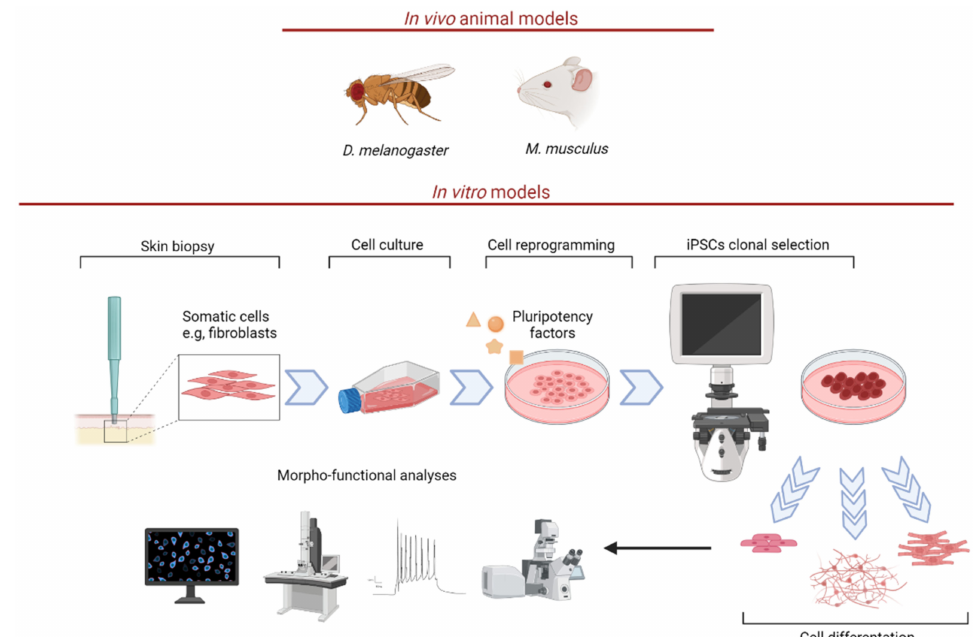
Figure 2. RTD in vivo and in vitro models. Proper RTD animal models include M. musculus and D. melanogaster. Note that C. elegans was also used to mimic human RF metabolism deficiency. In vitro models include patient-specific fibroblasts and iPSCs, which can be differentiated into MNs. Indeed, skin biopsy-derived fibroblasts can be reprogrammed into iPSCs, thanks to the introduction of specific pluripotency factors. Human iPSCs may be differentiated into cell types. In the figure, as an example intestinal epithelium, muscle, and neurons, as representative derivatives from endoderm, mesoderm and ectoderm germ layers, are illustrated. Neurons may be studied using diverse mor- phofunctional approches (e.g., confocal and electron microscopy, electrophysiology) The figure was created with BioRender.com (accessed on 13 April